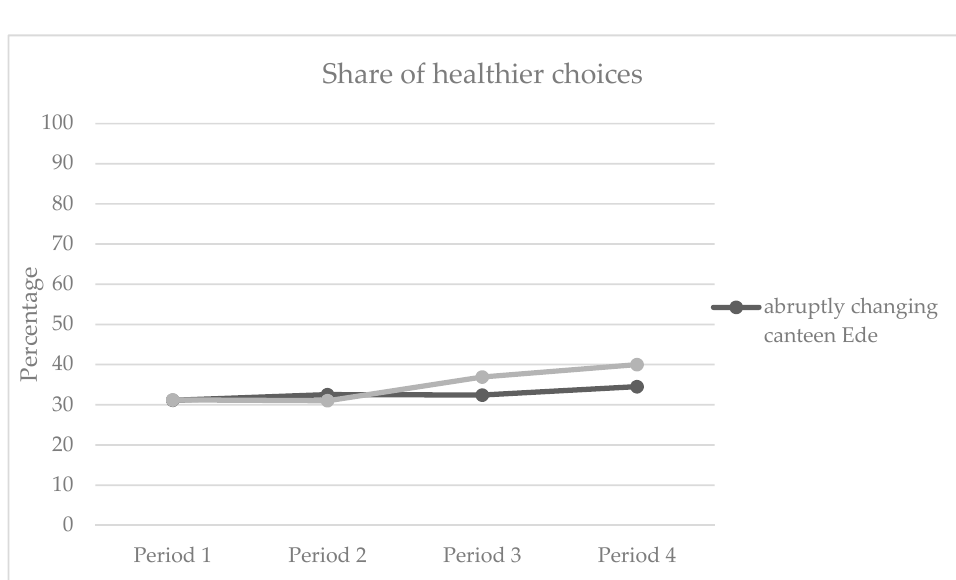
Figure 2. Share of healthier products sold across four time periods in Ede and Velp. Table 6. Regression results hypothesis 2 and additional measures.